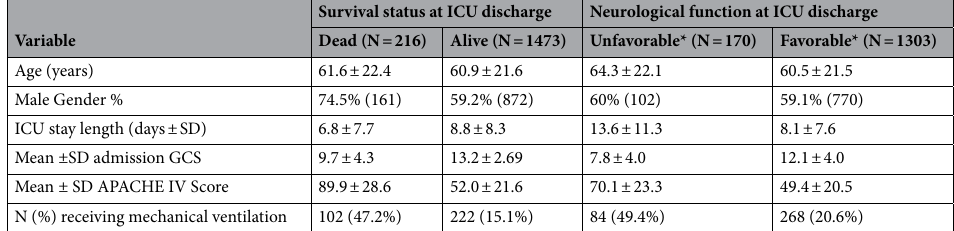
Table 1. Characteristics of patients in eICU multi-center database used for training machine learning models. Unfavorable neurological outcome refers to patients with Glasgow Coma Scale motor subscore of < 6 at the time of discharge. Favorable neurological outcome refers to patients with Glasgow Coma Scale motor subscore of 6 at discharge. GCS Glasgow Coma Scale, APACHE acute physiology and chronic health evaluation.